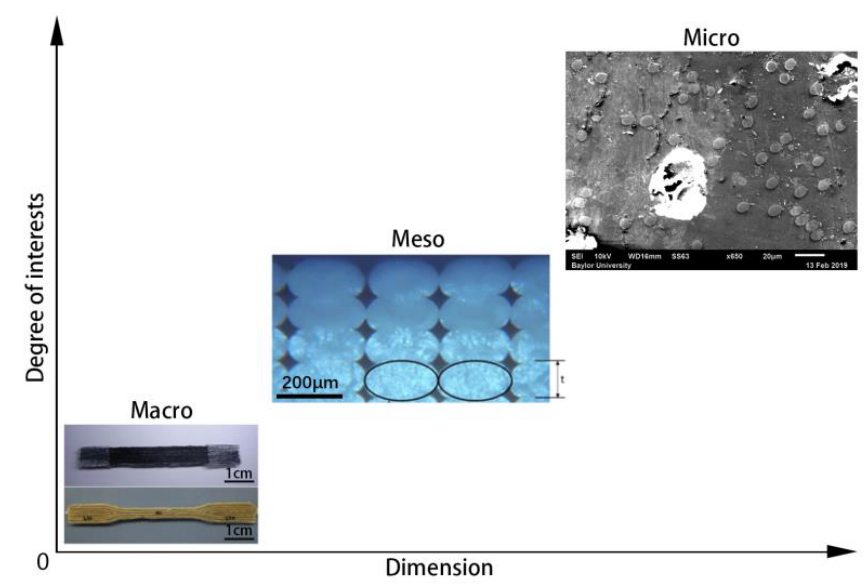
Figure 3. Structural formations of composite materials produced via